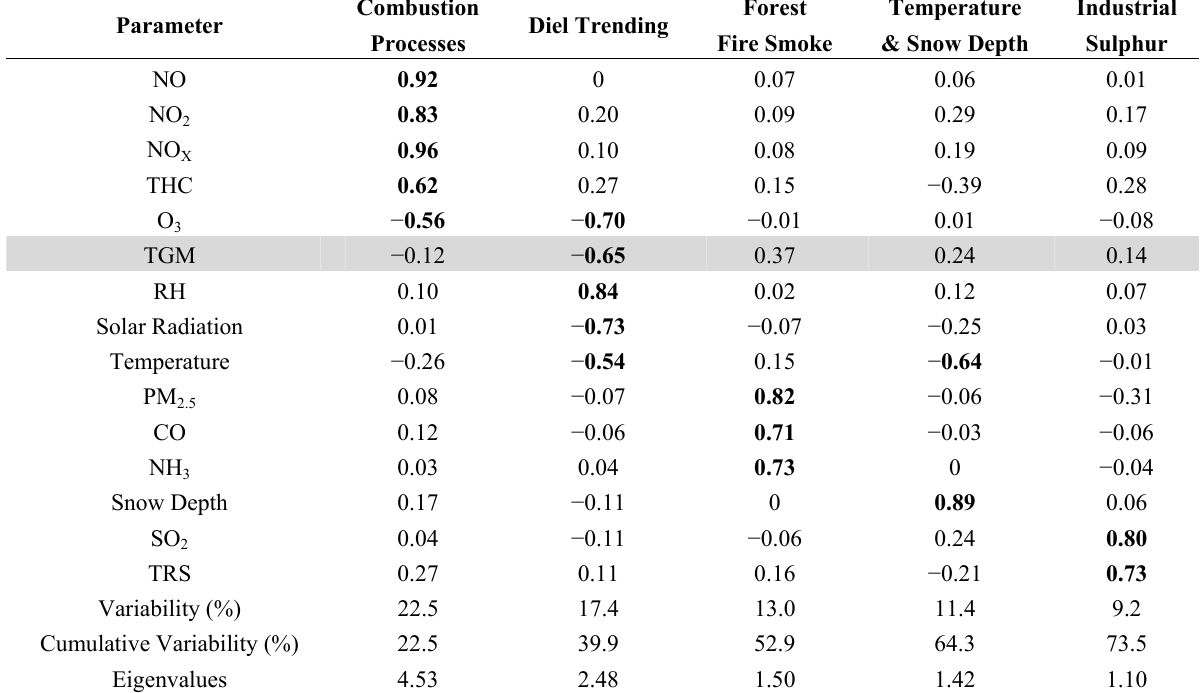
Table 5. PCA rotated factor loadings for the full, combined dataset. Factor loadings with an absolute value greater than or equal to 0.5 are bolded. The shaded row highlights TGM loadings on each